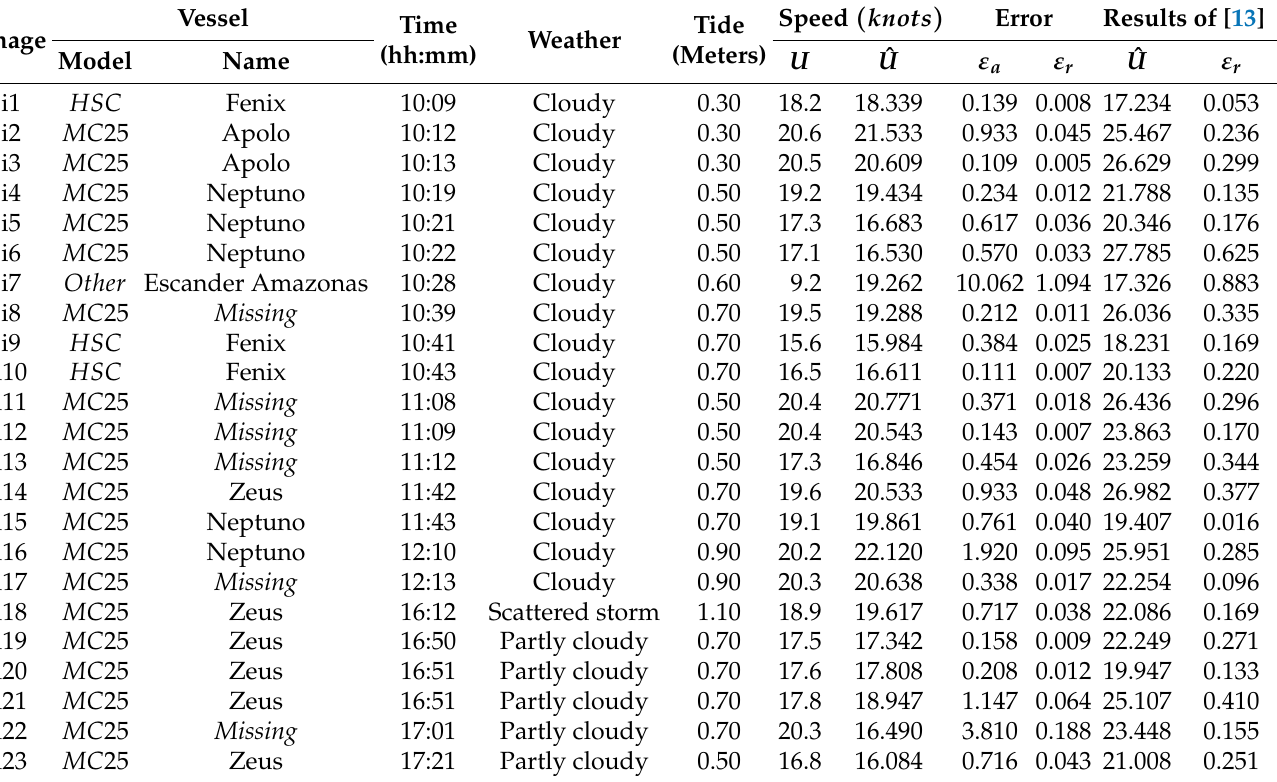
Table 2. Information regarding each captured image, where U denotes the speed that was measured by a radar (ground truth), ˆ U is the speed that was estimated by our approach using the troughs of the wave arms, and ε a and ε r are the absolute and relative errors of estimations, respectively. The subtable summarizes the results of Huillca and Fernandes